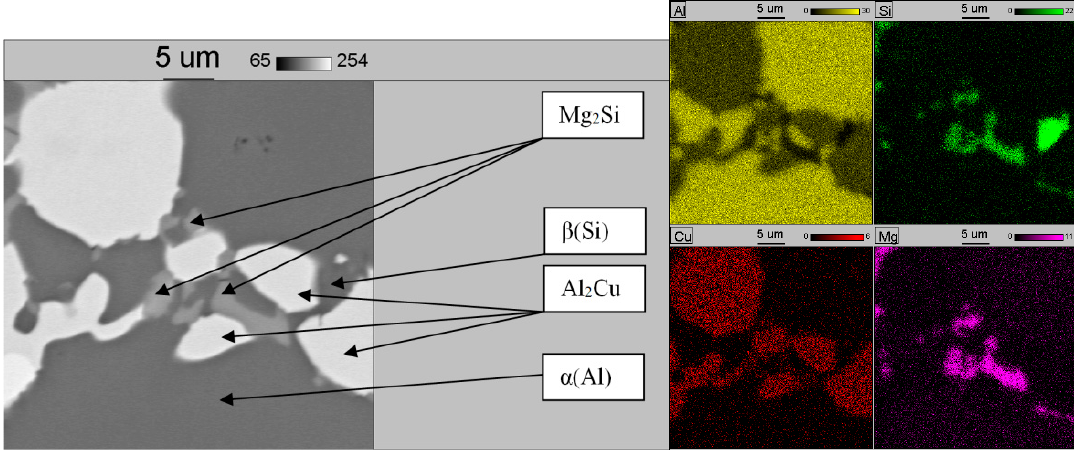
Figure 5. An example of the quaternary eutectic region of EN AC-4600 alloy and a map of Al, Si, Cu, and Mg distribution.